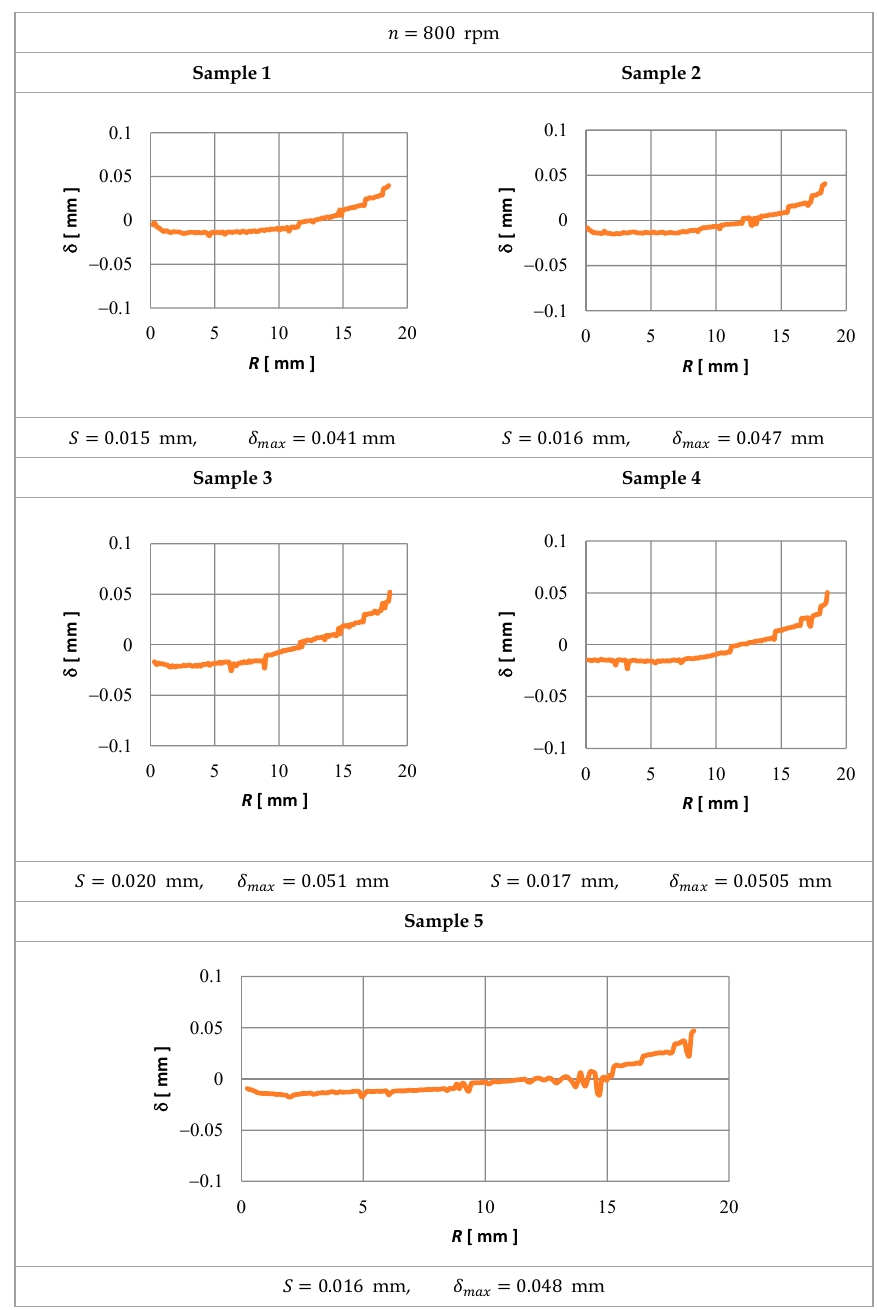
Figure 18. Distribution of shape deviation δ along the length of coordinate 𝑅 .